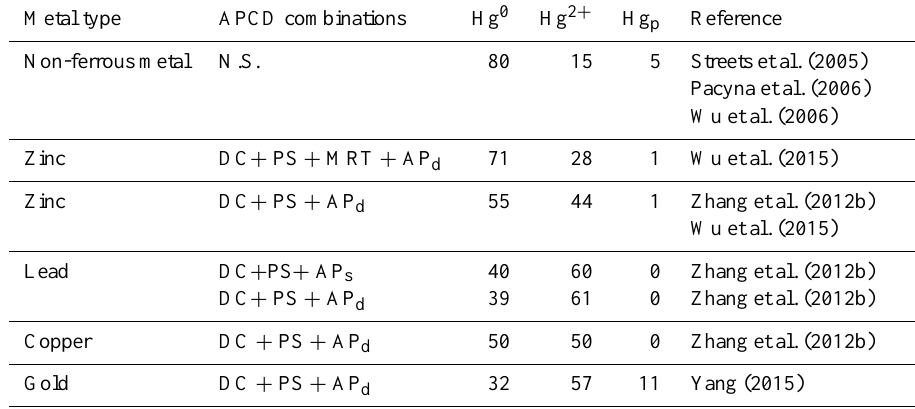
Table 2. Average speciation profiles of mercury emissions from non-ferrous metal smelters by control technology (%).